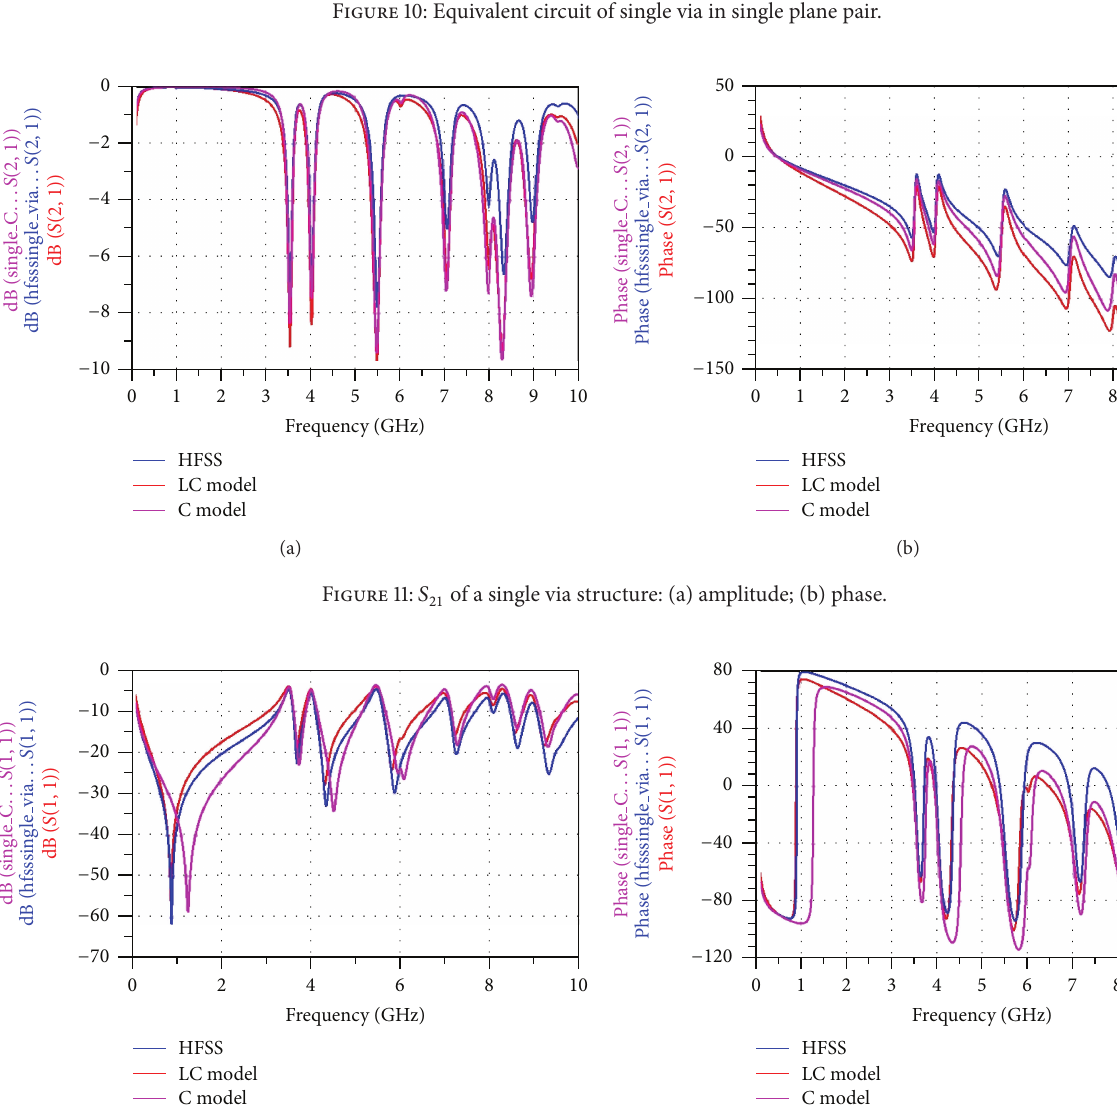
Figure 10: Equivalent circuit of single via in single plane pair.